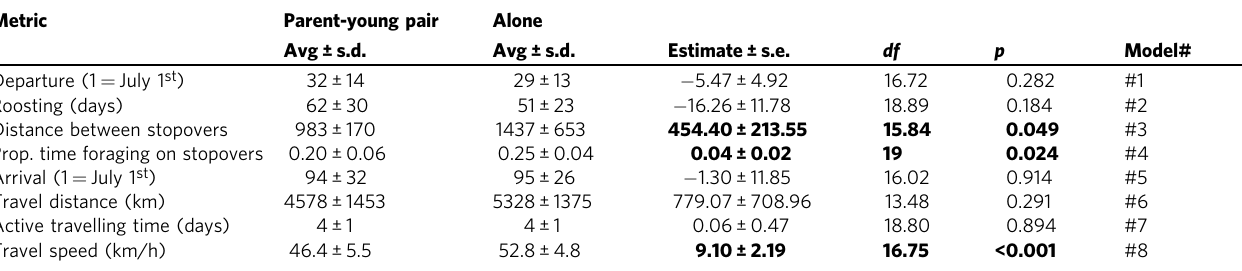
Table 1 Migration metrics and the results of GLMMs (Family ID speci fi ed as random intercept) as compared between pairs of parents and young and solo-migrating birds from the same family group.